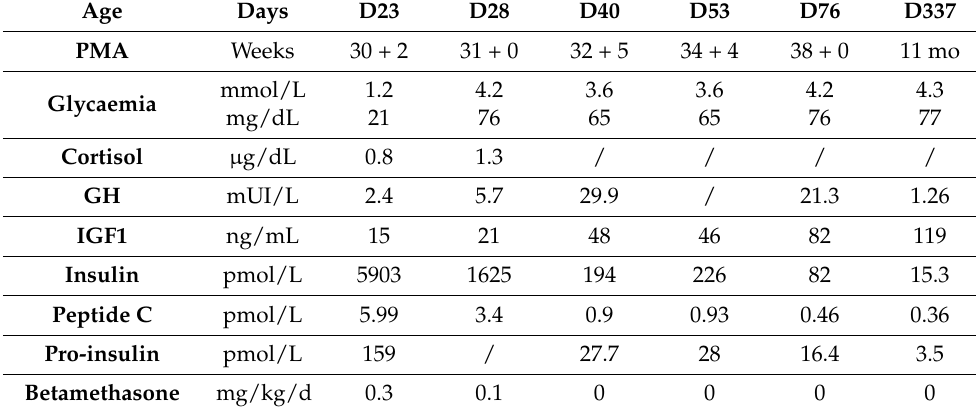
Figure 1. Evolution of capillary glycaemia (mg/dL, on left scale and on blue line) and concomitant nutritional intakes (g/kg/day, on right scale and with red dots for glucose intakes and green dots for lipids intakes) within days. Shaded area represents betamethasone administration period during day 21 and 30 of life. Table 1. Evolution of hormonal assays during hospitalization and at 11 months old. PMA: postmen- strual age; GH: growth hormone; IGF1: insulin-like factor 1; D: days; mo: